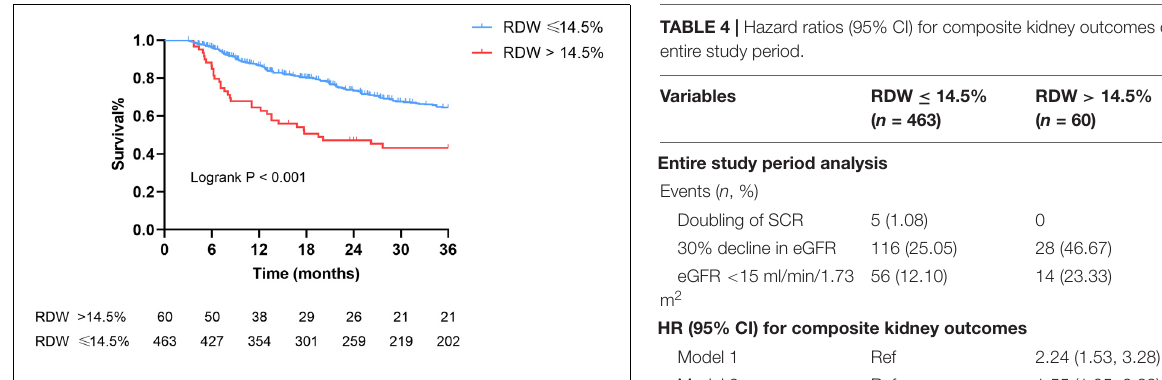
FIGURE 4 | Kaplan–Meier survival curves of composite kidney outcomes according to RDW levels. (Log-rank test, P < 0.001). The numbers below the x -axis indicate the number of event-free patients observed at 6, 12, 18, 24, 30, and 36 months.